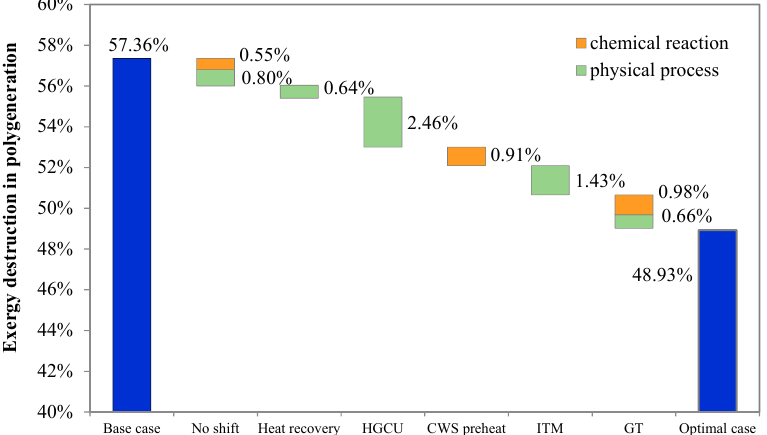
Figure 12. Potential exergy loss reductions for a coal-based polygeneration system.